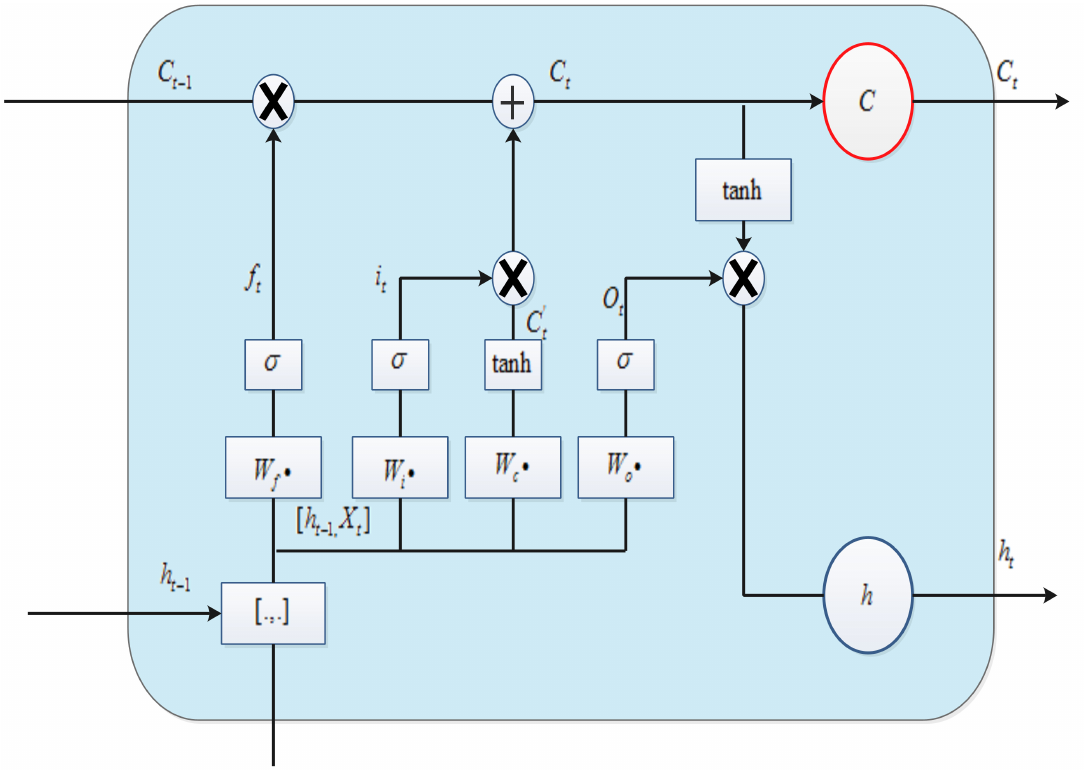
Figure 3. Long short-term memory